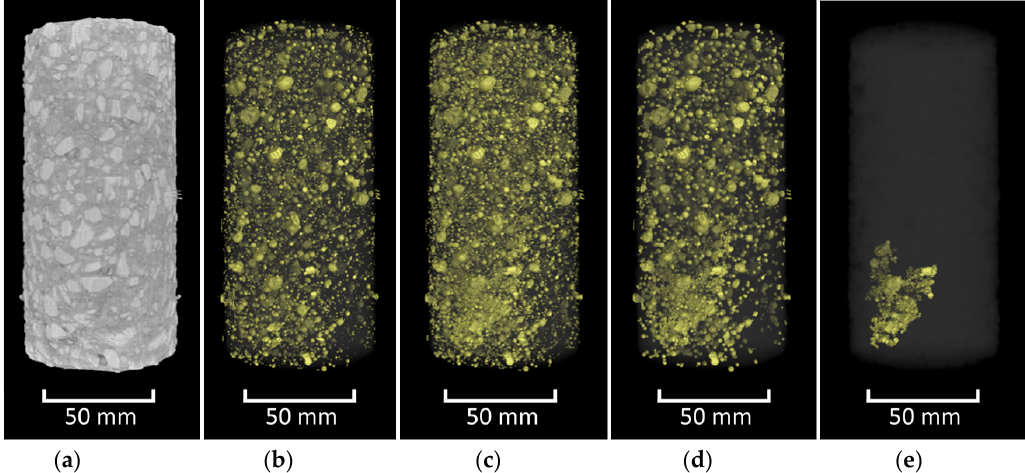
Figure 3. Step-by-step isolation of cracking by means of virtual data fusion. CT image of a concrete sample ( a ), voids identified using a greyscale threshold ( b ), voids identified in ( b ) added to interfacial zones identified using a gradient-based analysis ( c ), removal of small connected components (noise and isolated pores) from image ( d ), and elimination of components with small specific surface areas from image ( e ). Raw data courtesy of U.S. Army Engineer Research and Development Center